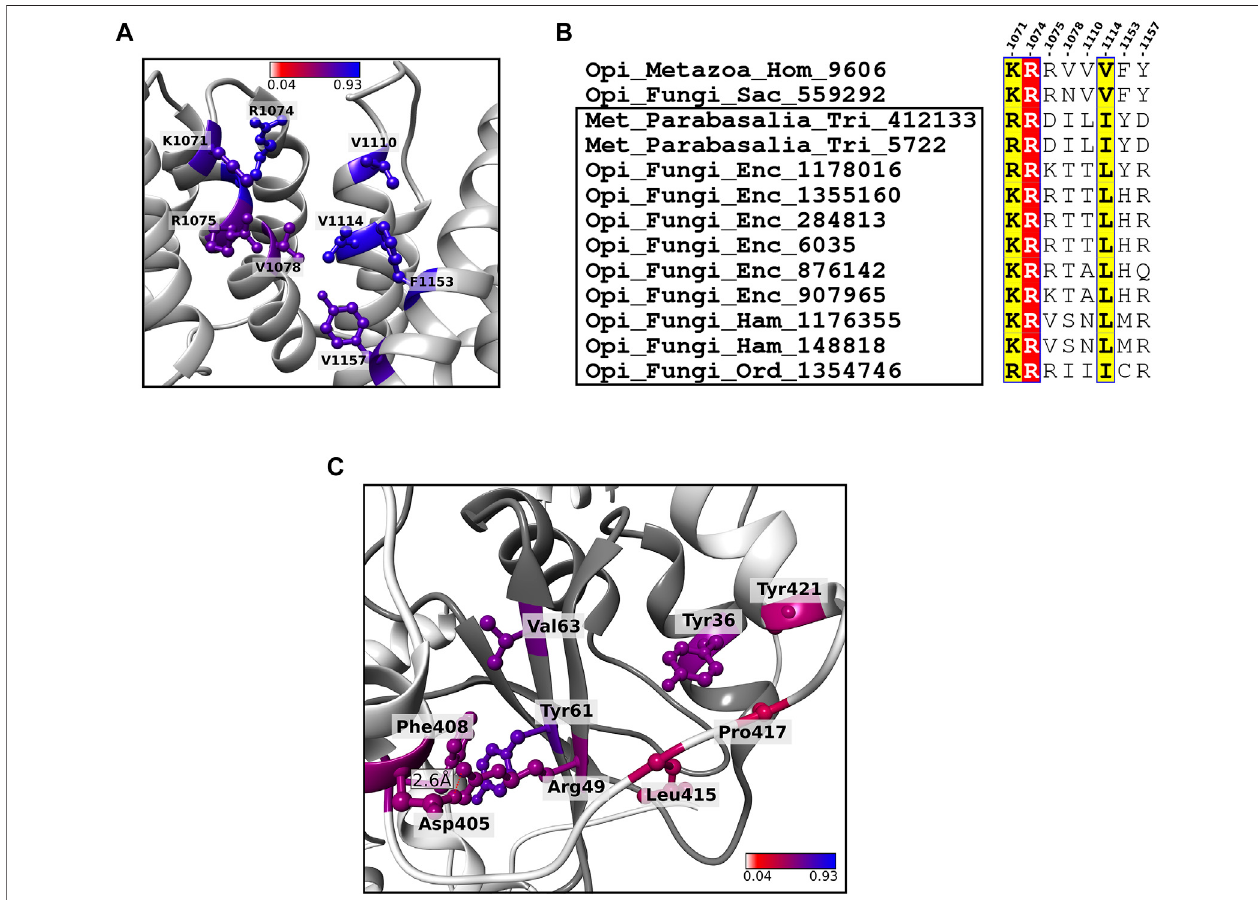
FIGURE6| ResidueconservationofkeyfunctionalresiduesinSF3b1andSF3b6. (A) ShownisthecartoonrepresentationofSF3b1focusedatknownanti-cancer drugbinding site. The8drug bindingsites arehighlightedin aball andstickrepresentation and coloredbased onthe conservationscore. (B) Sequence alignment ofthe 8 anti-cancer drug binding sites in the SF3b1 from humans, yeast and 11 pathogenic species (highlighted within the black box) in which physicochemically non- synonymousresidue substitutions are observed. Thewellconservedsites arehighlightedby red and yellow background asper ESPript format (Robert and Gouet, 2014). (C) The cartoon representation shows SF3b1 (light grey) and SF3b6 (dark grey) in the complexed form. Shown in the ball and stick representation are core interface residues proposed ascritical residues that stabilizethe SF3b1/SF3b6 complex. Residues are recognized based on the conservation patternand contributions to energy and the geometry of the complex. The color code of these residues is the same as in (A). Hydrogen bond formed at the core interface is shown by the red dashed line.